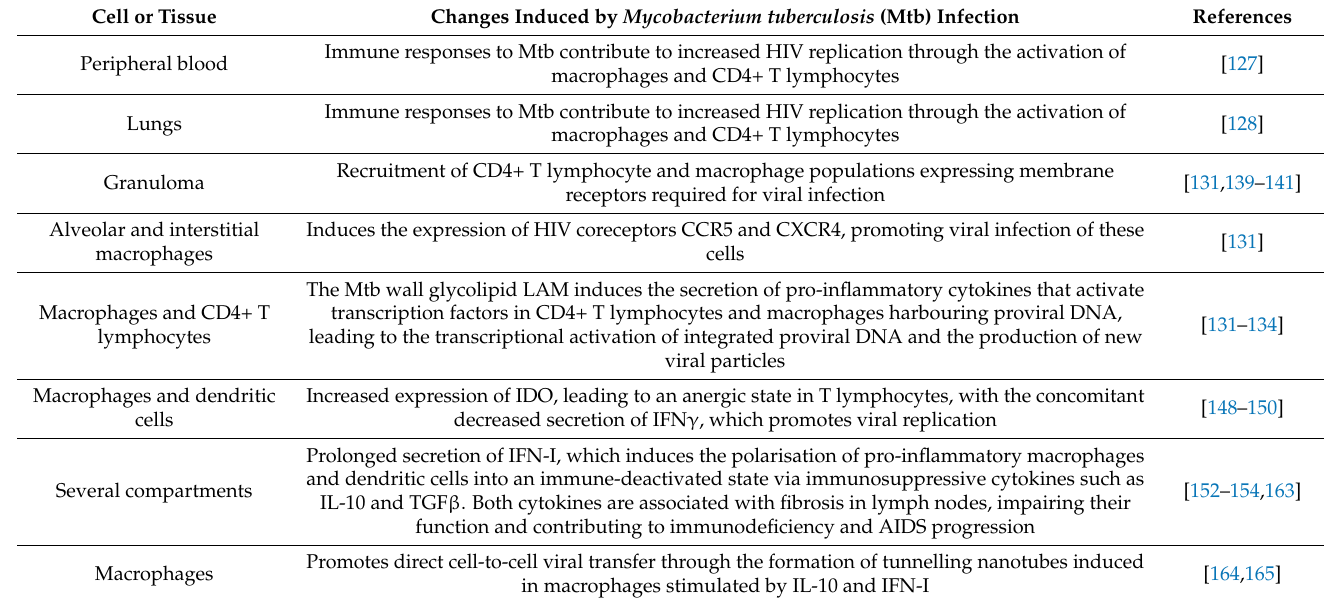
Table 2. Mtb-induced changes in various cells and tissues that directly affect the immune response and control of HIV